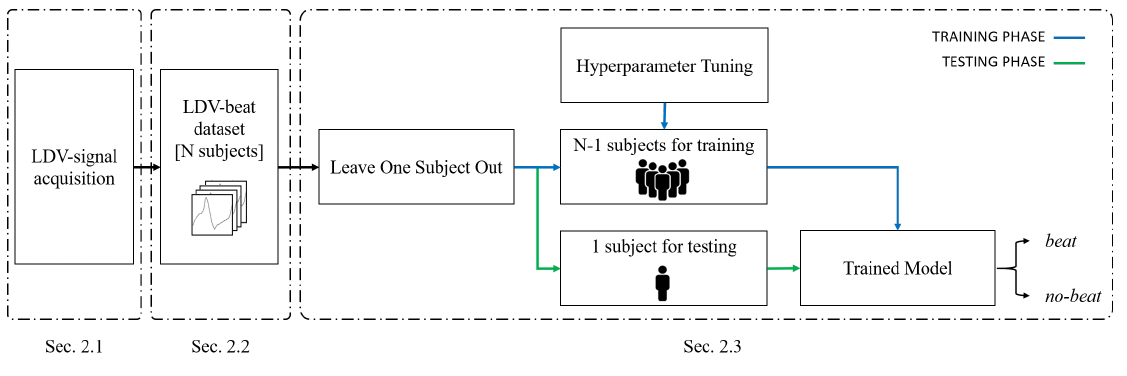
Figure 2. Workflow of the proposed machine-learning (ML) framework to heartbeat detection from carotid LDV